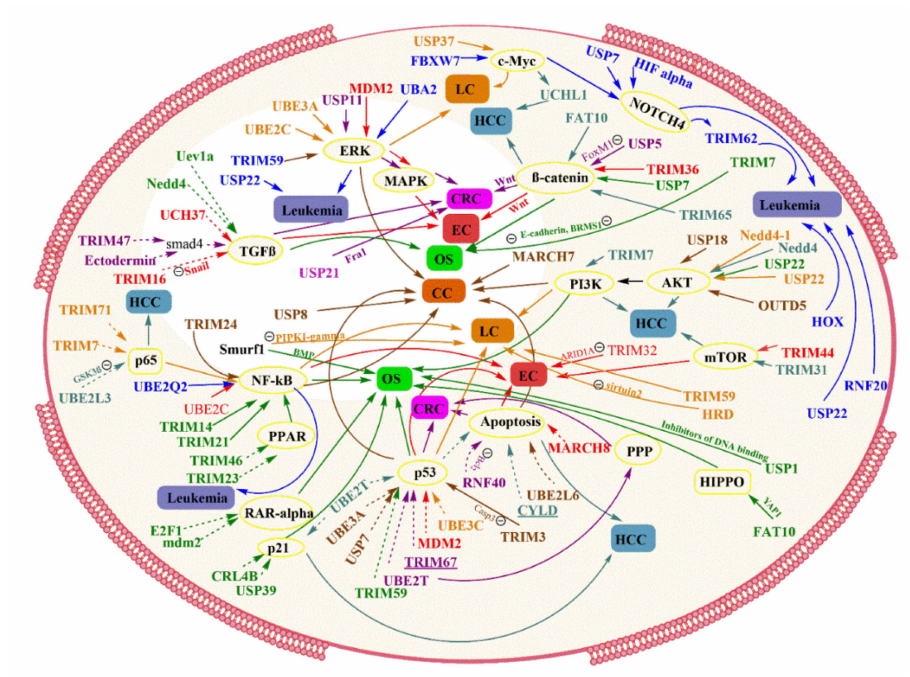
Figure 5. The figure represents various physiological roles of UPP and the enzymes/proteins involved. CRC; colorectal cancer, EC; esophageal cancer OS; osteosarcoma, LC; lung cancer, HCC; hepatocarcinoma cells, CC; cervical cancer,